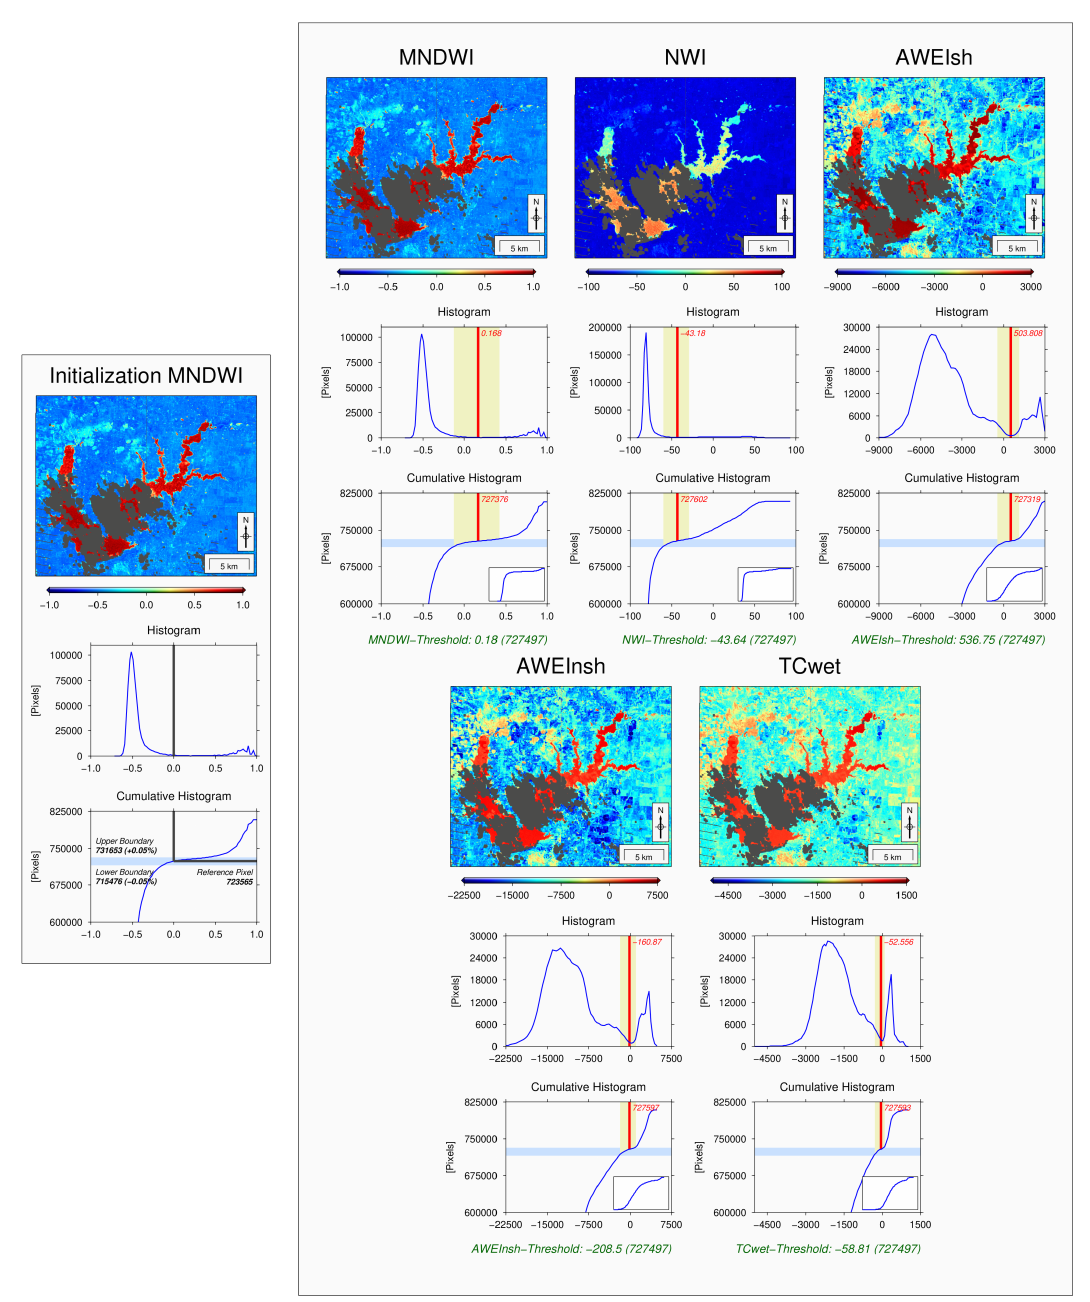
Figure 8. Calculation of the thresholds for the land-water classification and its derived land-water masks using five water indexes shown exemplary for the Lake Ray Roberts in January